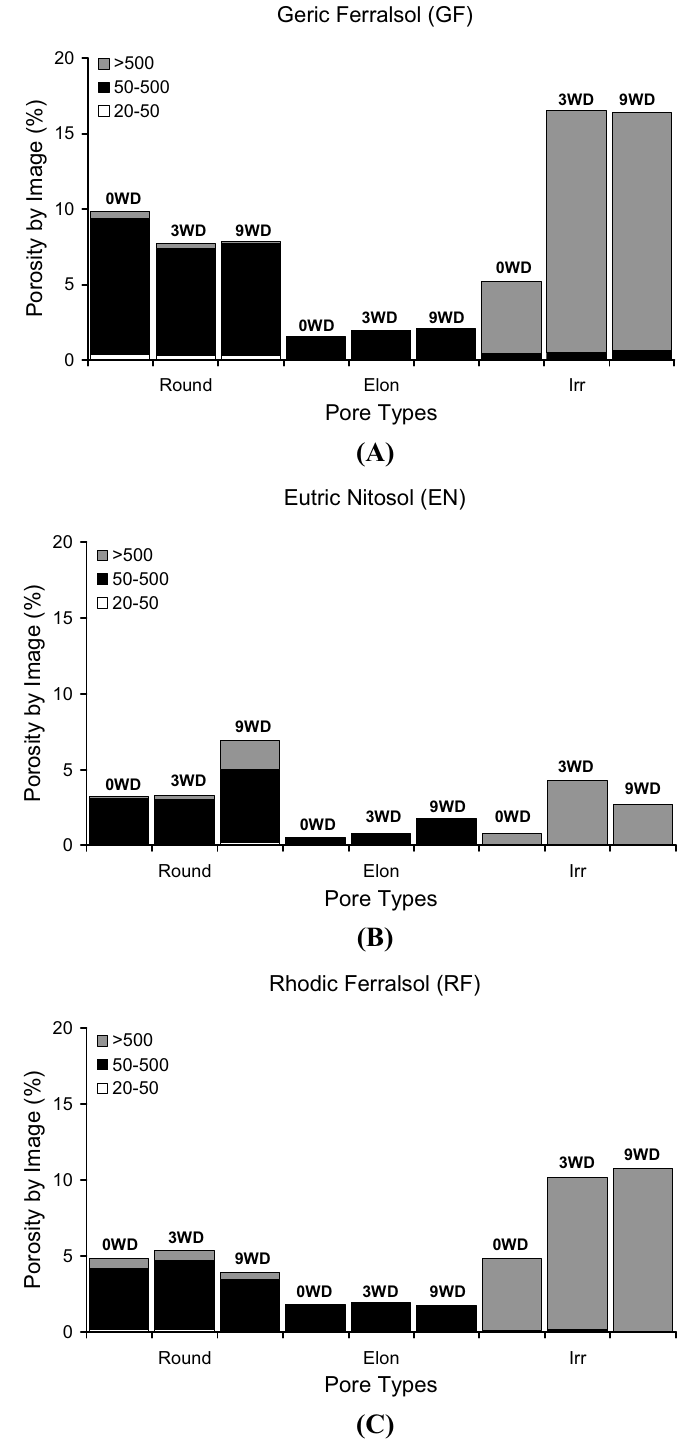
Fig. 4 – Effects of wetting and drying (W-D) cycles on the pore size distribution of damaged samples. Round = rounded; Elon = elongated; Irr = irregular; 0WD (samples not submitted to W-D cycles), 3WD (samples submitted to 3 W-D cycles), and 9WD (samples submitted to 9 W-D cycles) treatments.